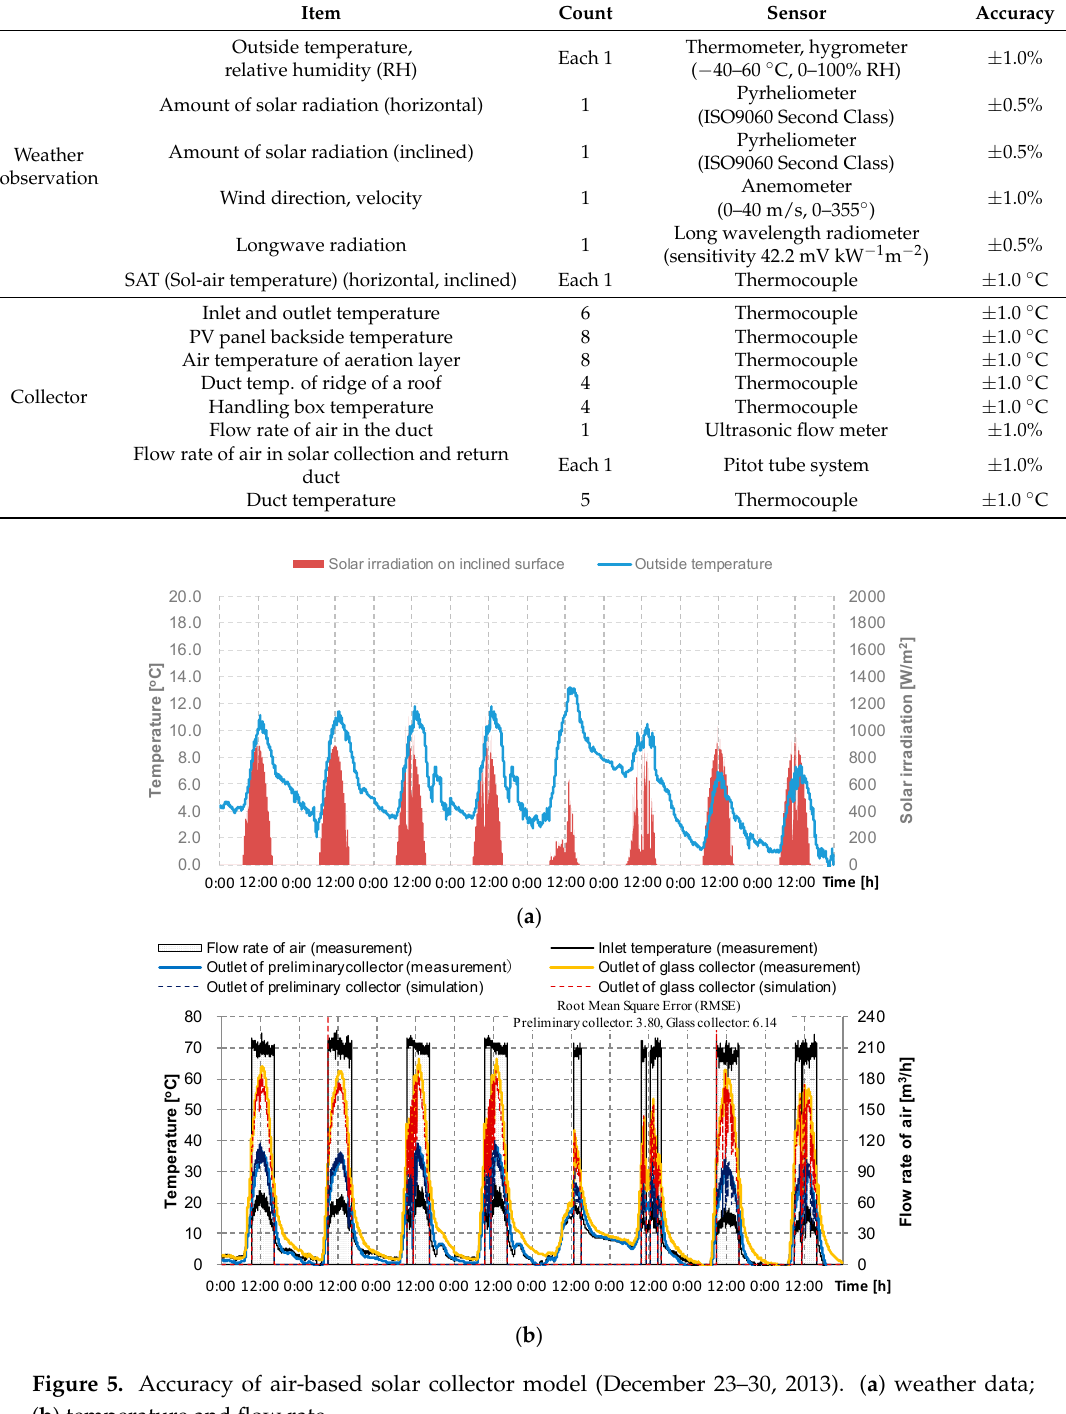
Figure 5. Accuracy of air-based solar collector model (December 23–30, 2013). ( a ) weather data; ( b ) temperature and flow rate.